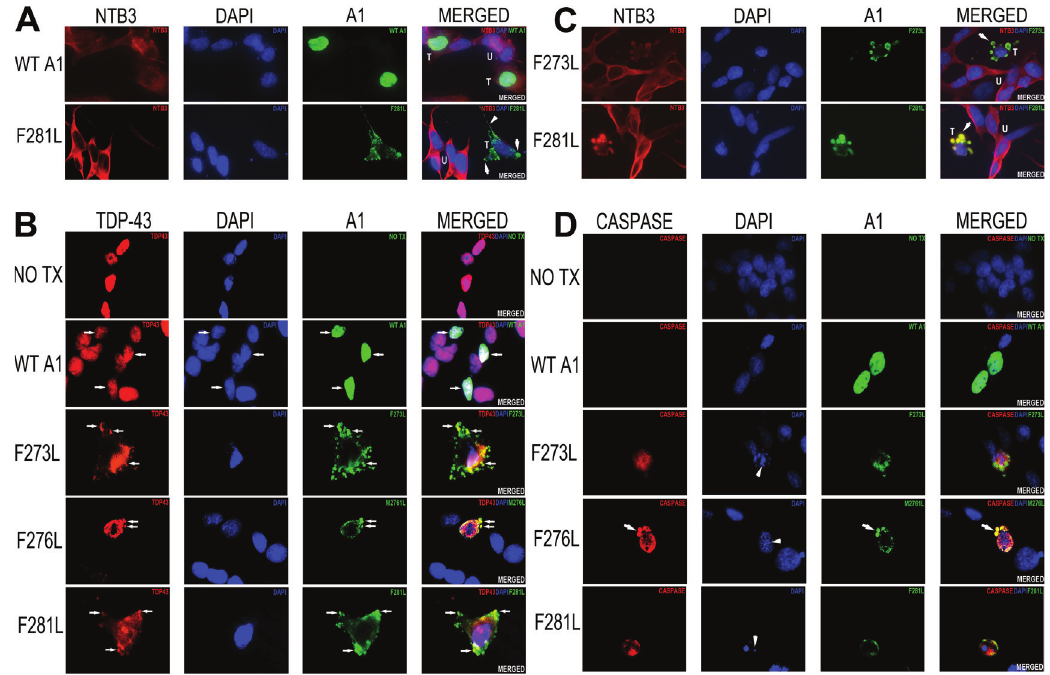
Figure 2. Transfection of WT and mutant forms of hnRNP A1 into SK-N-SH cells. A . Localization of WT and F281L hnRNP A1 . (upper panel) hnRNP A1 localizes to the nuclei of cells transfected (T) with WT hnRNP A1. Untransfected (U) cells are also present in the same field. (Lower panel) In contrast, mutant hnRNP A1 (F281L) mis-localizes to the cytoplasm including cellular processes (arrowhead) in a granular pattern, consistent with stress granule (SGs) formation (arrows) (NTB3-Neuron specific beta III tubulin). B . Co-localization of hnRNP A1 and TDP-43 . TDP-43 localizes to nuclei of neurons (‘no tx’) (pink or red signal). WT hnRNP A1 co-localizes with TDP-43 in nuclei (arrows). In contrast, mutant forms of hnRNP A1 (F273L, M276L, F281L) predominantly mis-localize to the cytoplasm and co-localize with TDP-43 positive SGs (arrows, yellow). Some TDP-43 remains in the nucleus (pink or red signal). Figures 2C and D: Apoptosis caused by mutant hnRNP A1 in SK-N-SH neurons. C . Transfection of mutant hnRNP A1 (F273L, F281) result in apoptotic blebs in transfected cells (T) (arrows), in contrast to untransfected (U) cells in the same field under identical conditions. D . Transfection of WT hnRNP A1 localized to the nucleus and showed no evidence of active caspase-3 labeling. In contrast, mutant hnRNP A1 (F273L, M276L, F281L) predominantly localized to the cytoplasm of cells that stained with active caspase-3, many of which with fragmented nuclei (arrowheads), both of which are indicative of apoptosis. There was also co-localization of active caspase-3 and mutant hnRNP A1